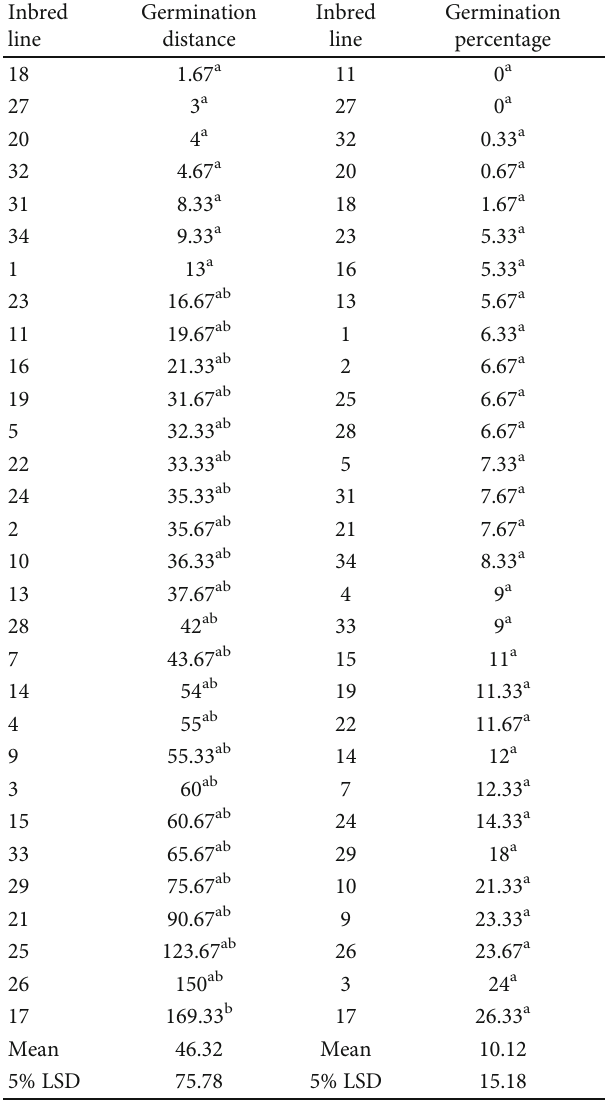
Table 3: E ff ects of maize genotypes on Striga asiatica seed germination distance and germination percentage.